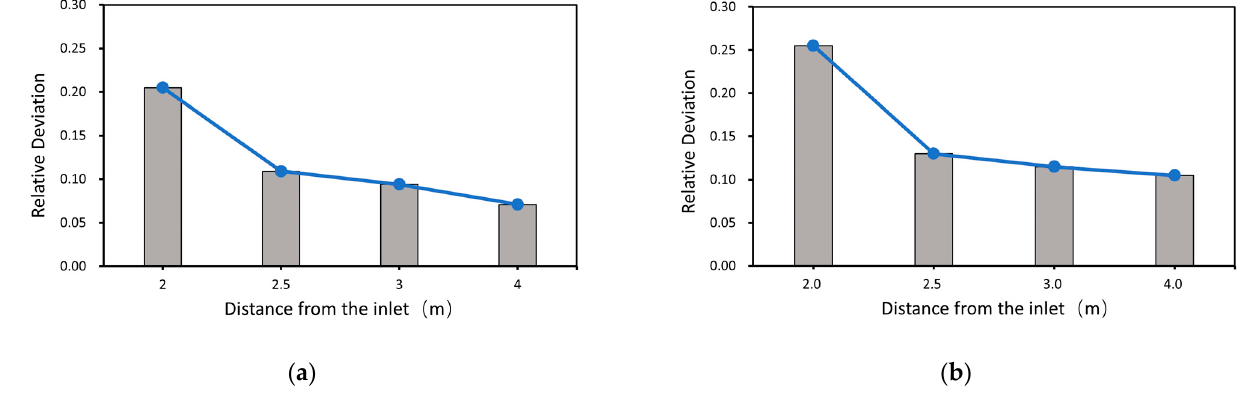
Figure 7. The relative deviation of the wind speed on the different sections. ( a ) case 1; ( b ) case 2.